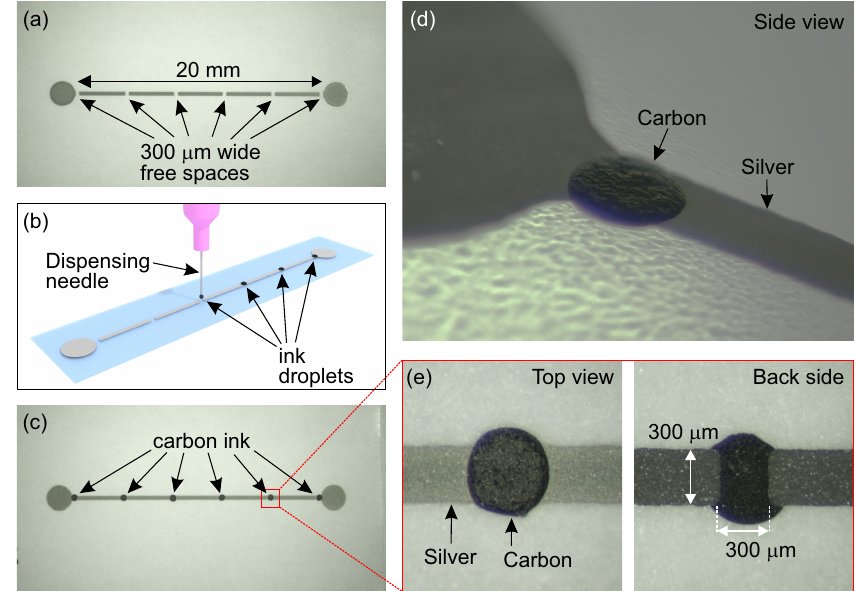
Figure 1. ( a ) Printed pattern of the intermittent structure made of silver ink. ( b ) Deposition of single droplets of the resistive carbon ink. ( c ) Top view on the fabricated strain sensor. ( d ) Side view on a carbon droplet. ( e ) Zoom in dried droplets made of the resistive carbon ink.